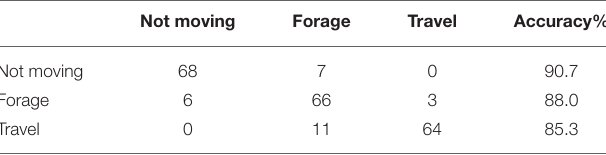
Overall accuracy is